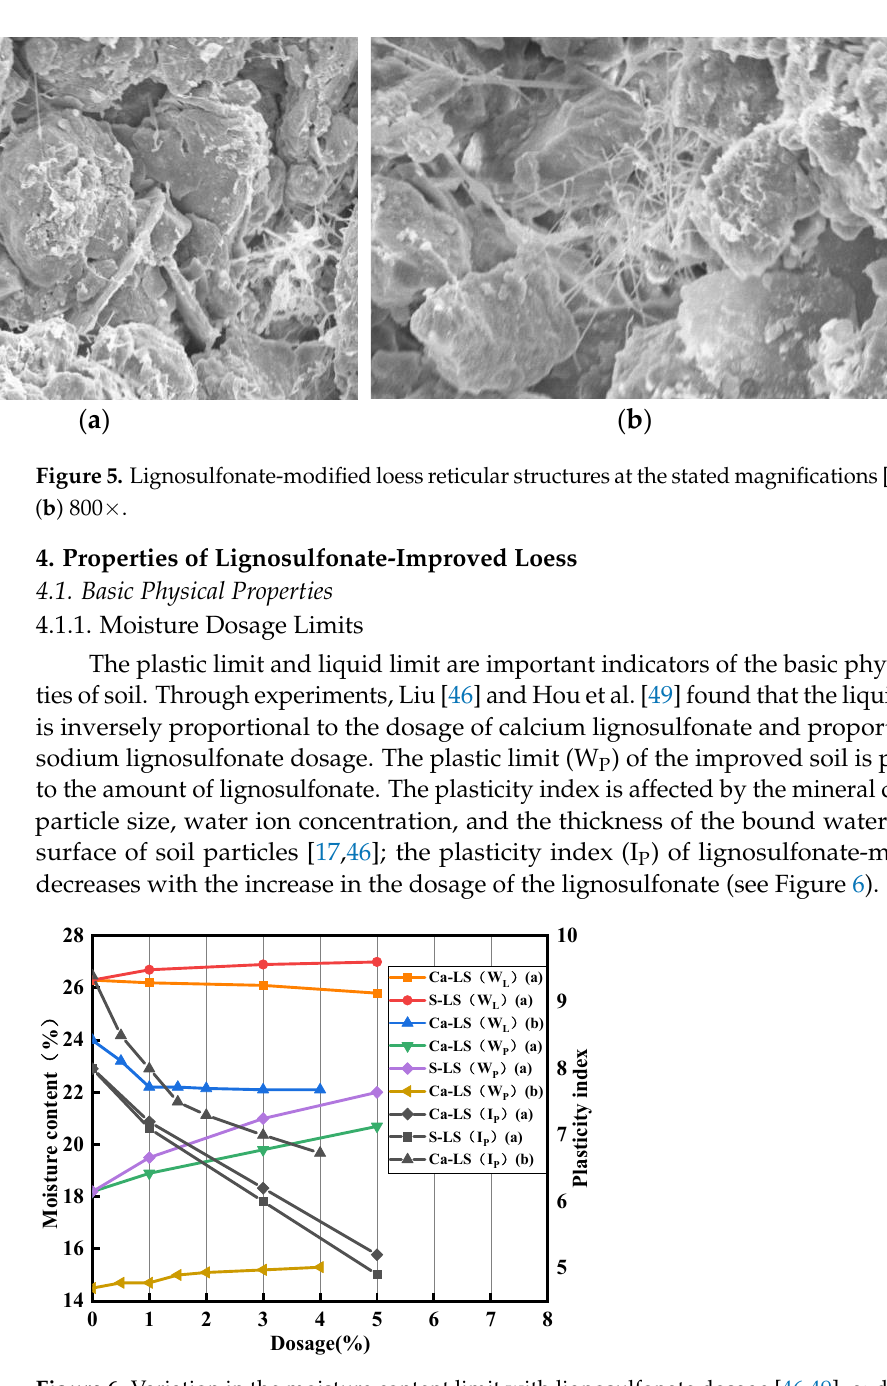
Figure 5. Lignosulfonate ‐ modified loess reticular structures at the stated magnifications [46]. ( a ) 500×; ( b ) 800×.